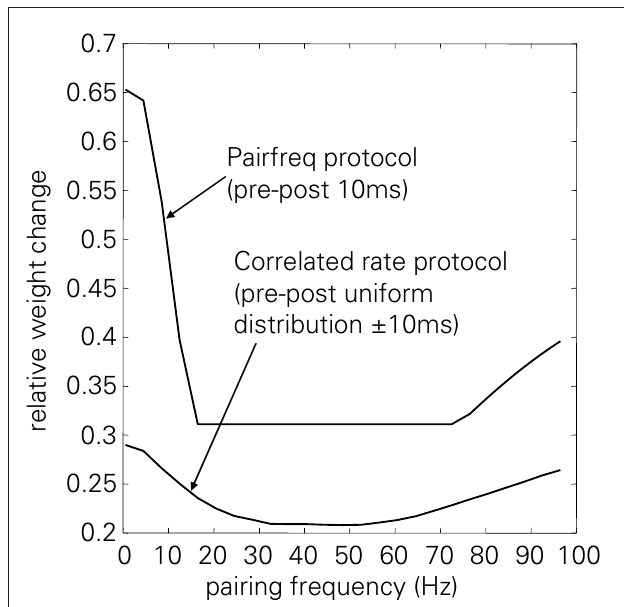
FigurE 15 | reproduction of frequency-dependent STDP (pre-post pairings) and of the correlated rate protocol for the revised suppression model of Froemke et al. (2006), parameters from Froemke et al.